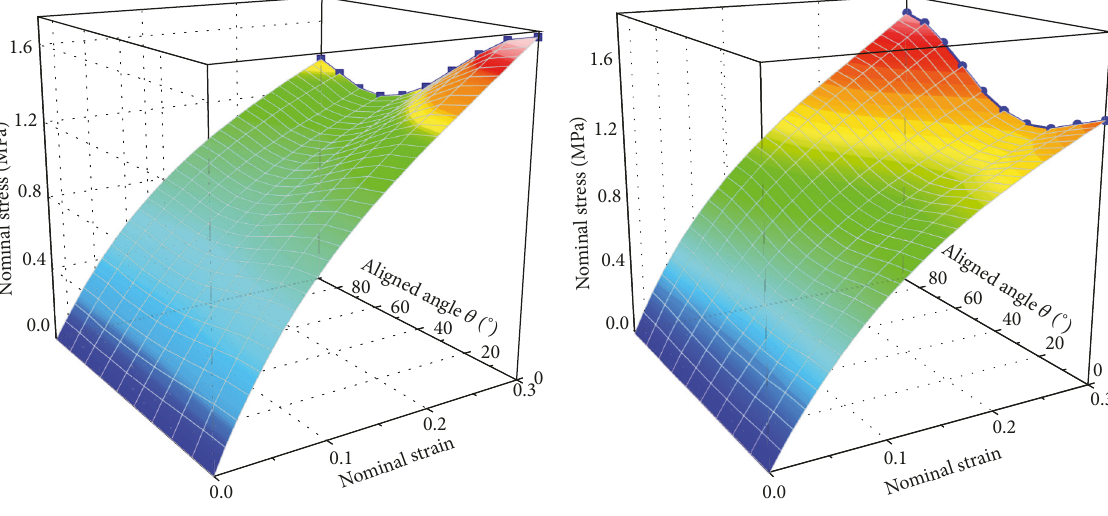
Figure 10: Response of stress–strain relationship of composites with an aligned angle 𝜃 of fibers, 𝑙 f =1.5 mm, and V f =0.0049.